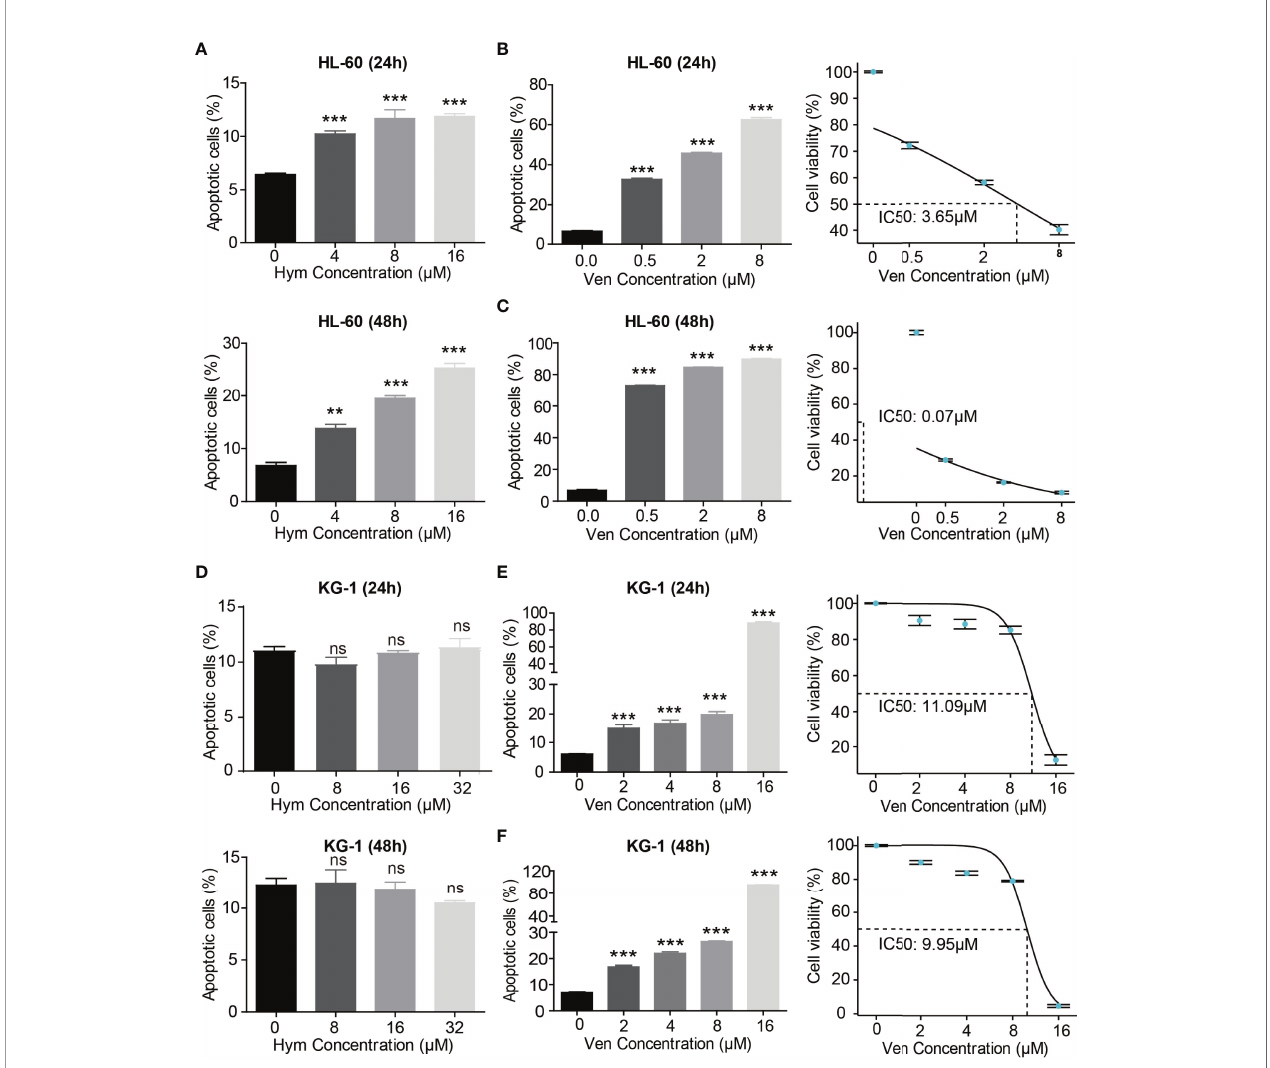
FIGURE 4 | Venetoclax and hymeglusin affect the apoptosis of AML cells. (A) The apoptotic rate after gradient concentration of hymeglusin (0 – 16 m M) treatment for 24 to 48 hours in HL-60 cells. (B, C) The apoptotic rate after gradient concentration of venetoclax (0 – 8 m M) treatment for 24 (B) to 48 h (C) in HL-60 cells. The cell viability curve indicating IC50 was shown in the right panel. (D) The apoptotic rate after gradient concentration of hymeglusin (0 – 32 m M) treatment for 24 – 48 h in KG- 1 cells. (E, F) The apoptotic rate after gradient concentration of venetoclax (0 – 16 m M) treatment for 24 (E) to 48 h (F) in KG-1 cells. The right panel shows the cell viability curve indicating IC50. **P<0.01, ***P<0.001. ns, not signi fi